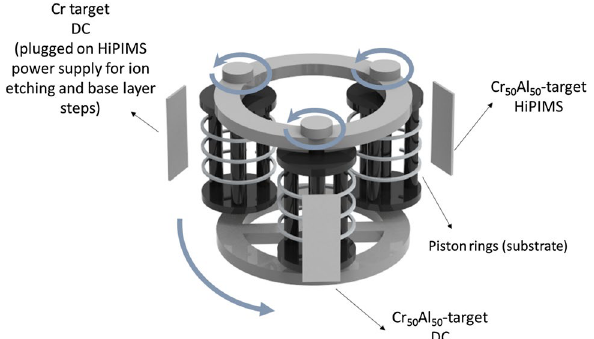
Figure 15. Scheme of the carousel rotation within the sputtering system mounted with gas-nitrided piston rings and three sputtering targets: two of a CrAl alloy (50–50 at.%) and one of pure